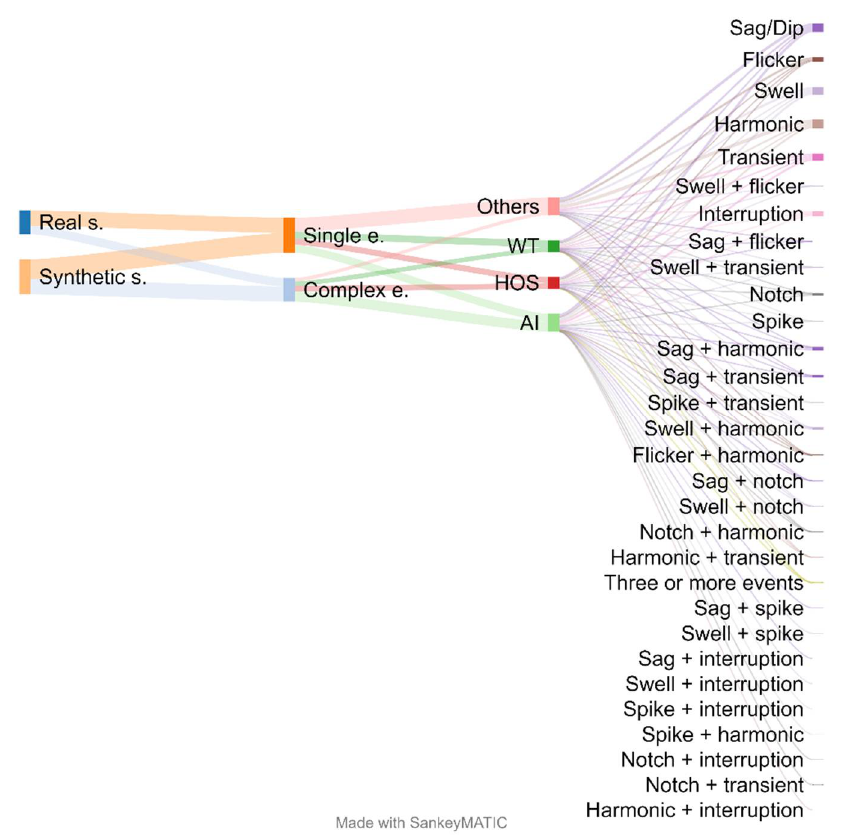
Figure 4. Parallel set that relates the signal source with the complexity of events, the method used, and the PQ disturbances.